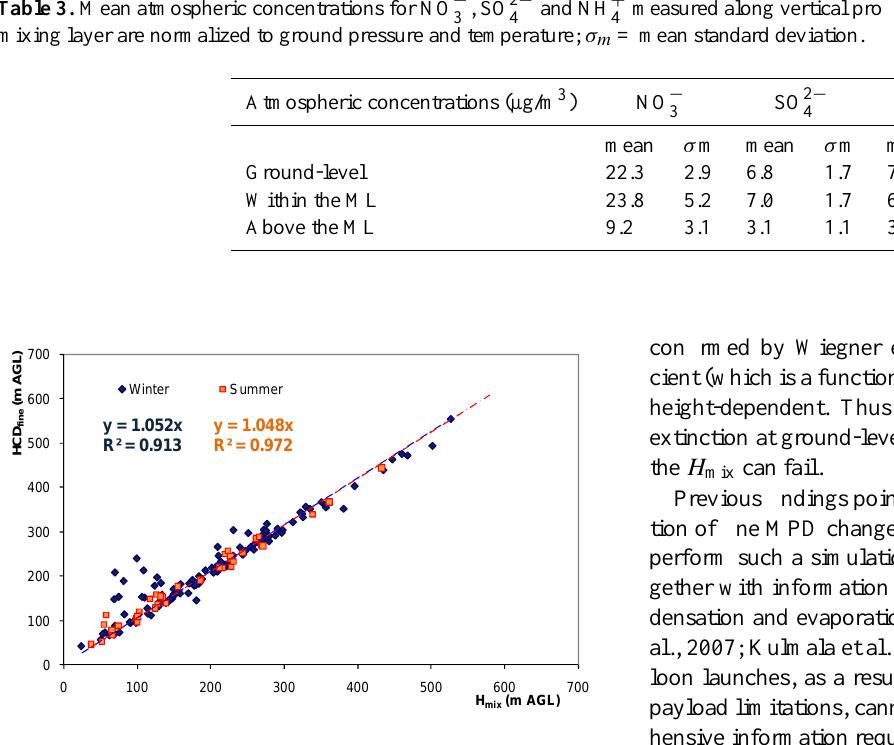
Fig. 9. Linear correlation between H mix and HCD fine in the winter (DJF months; N profiles=142) and summer (JJA months; N pro-